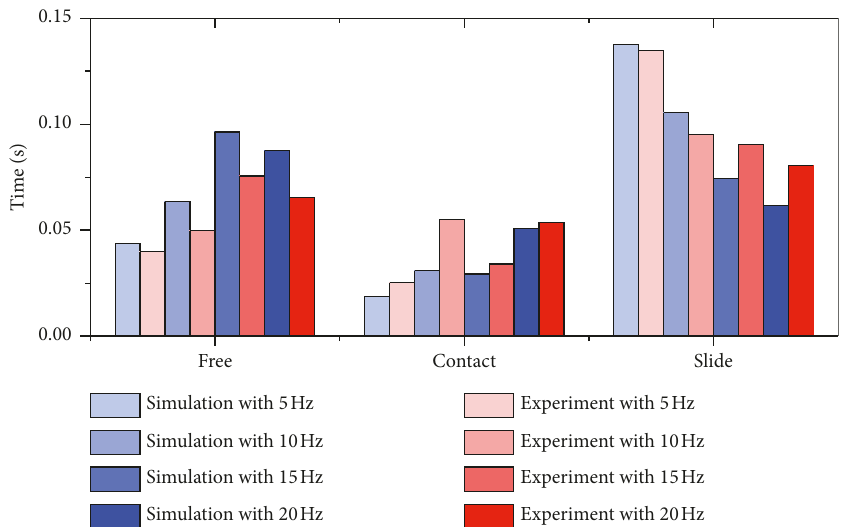
Figure 27: Statistical results of time in numerical and experimental studies with different frequencies.